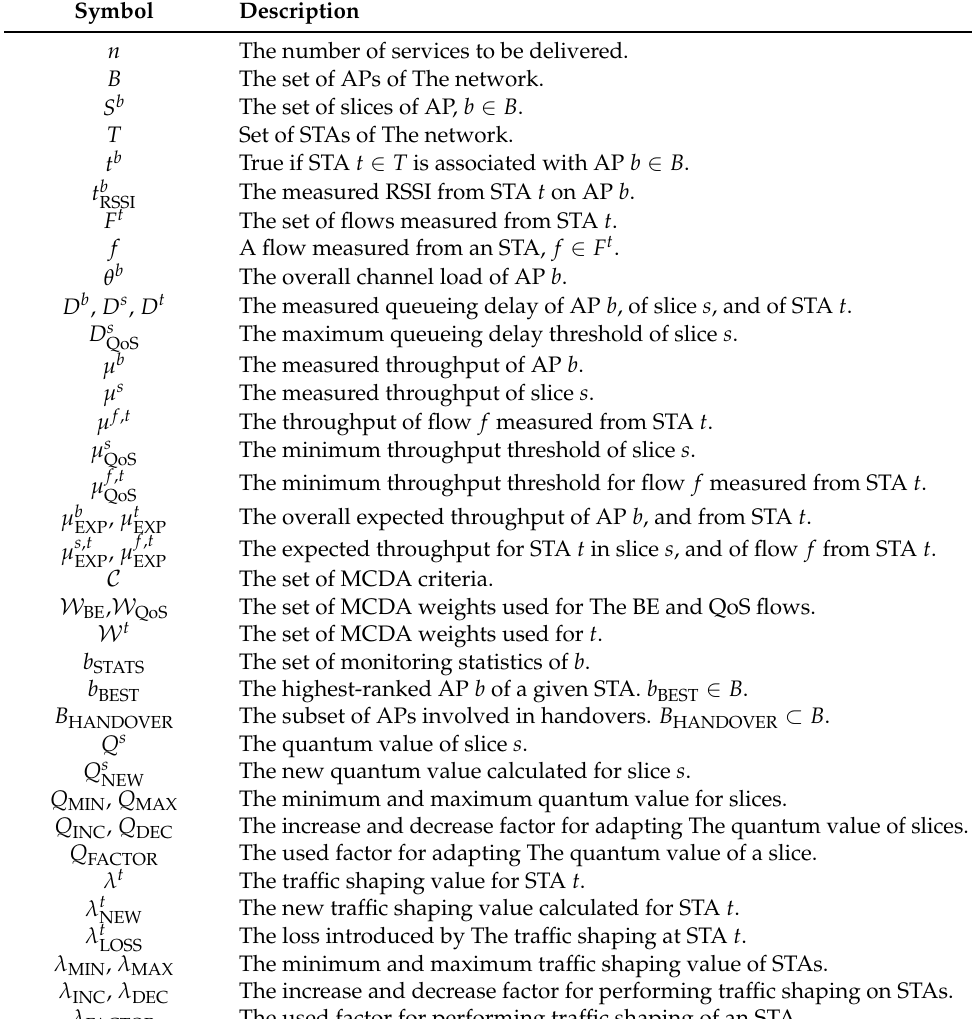
Table 3. Overview of notation